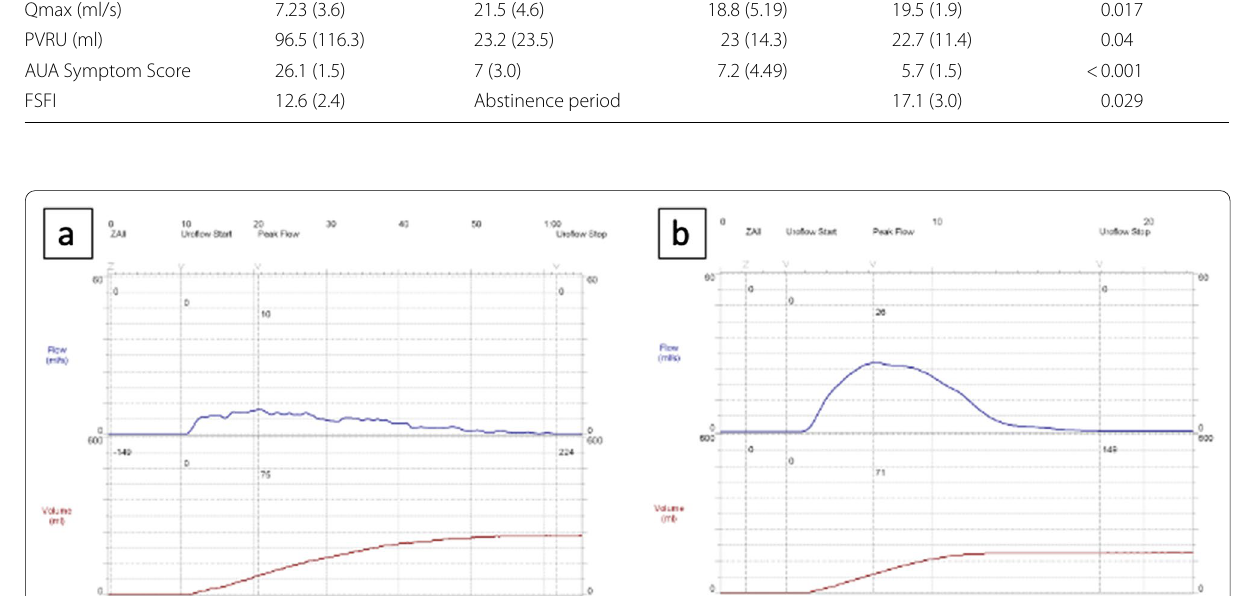
Fig. 4 Preoperative ( a ) & postoperative ( b ) uroflowmetry of the